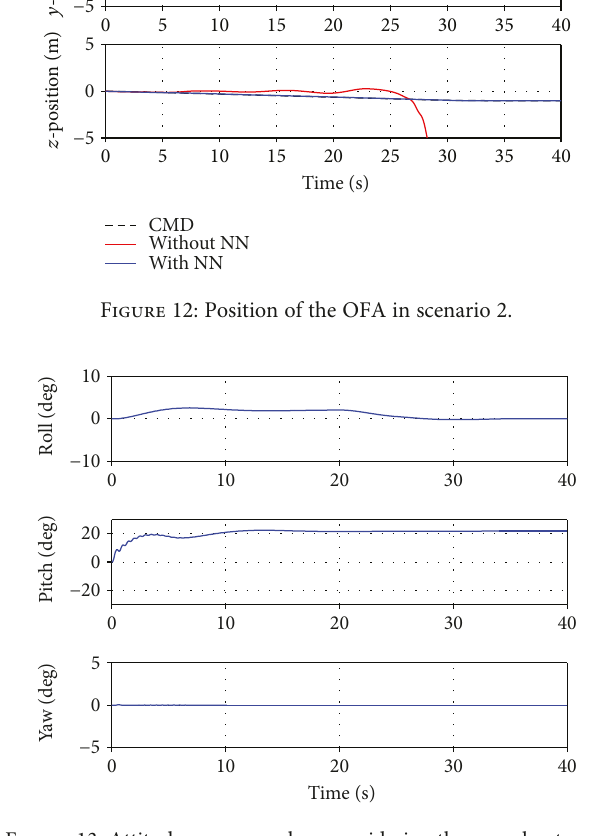
Figure 13: Attitude response when considering the neural network in scenario 2.